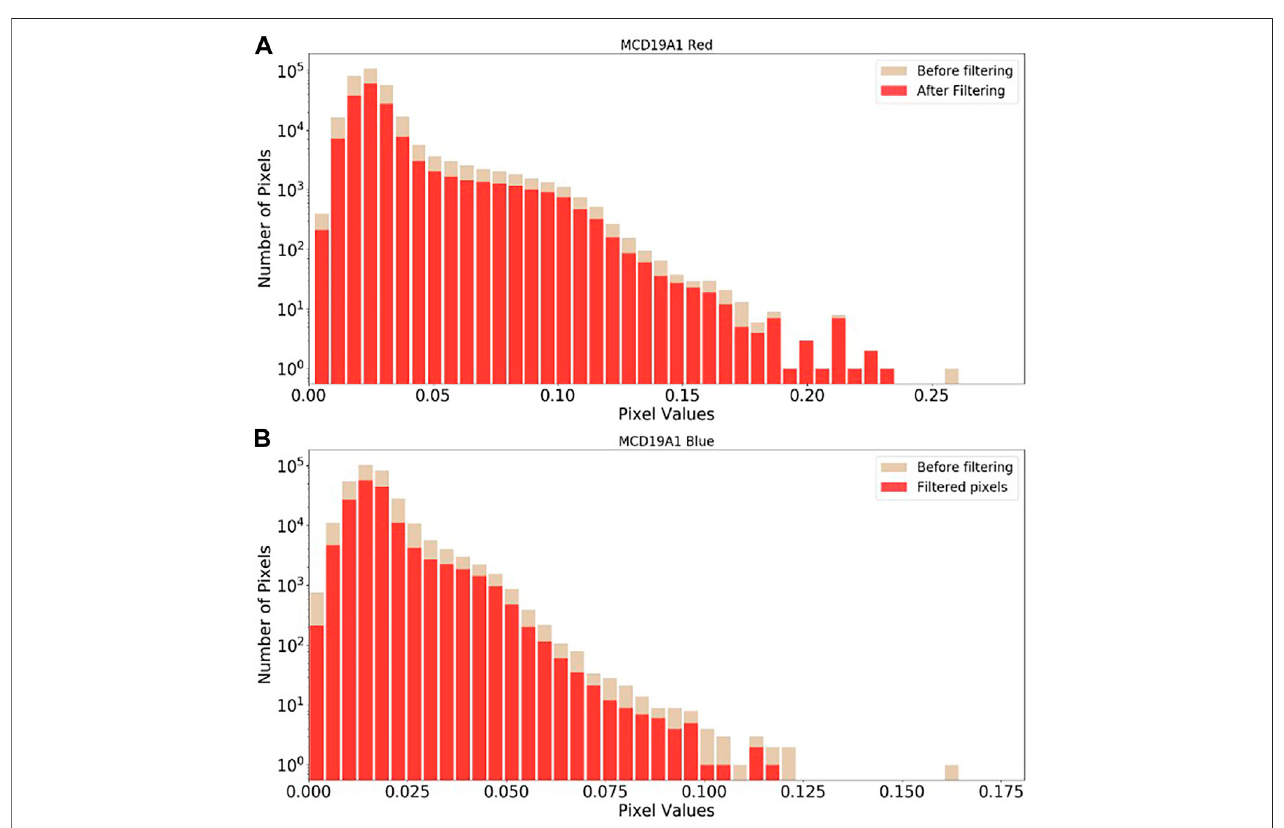
FIGURE4| MCD19A1SRhistogramsofun fi lteredand fi lteredwith “ AdjacencyMask ” QAfortheRed (A) andBlue (B) bandsforthesampleMODISH11V09scene of Figure 2 .